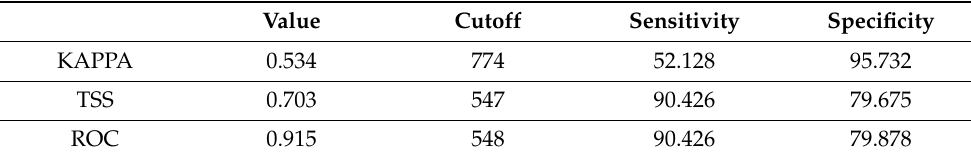
Table 3. Results of BIOMOD2 evaluation of Abies holophylla .